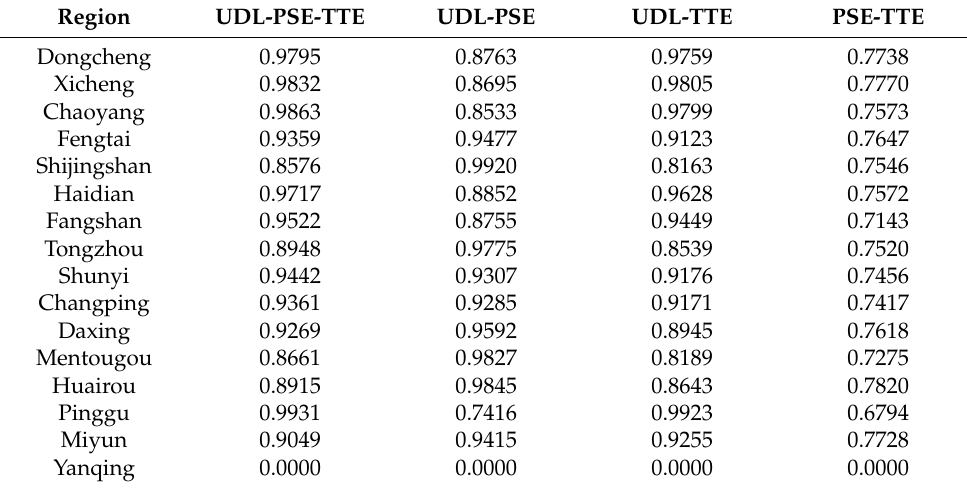
Table 4. Coupling relationships in different regions of